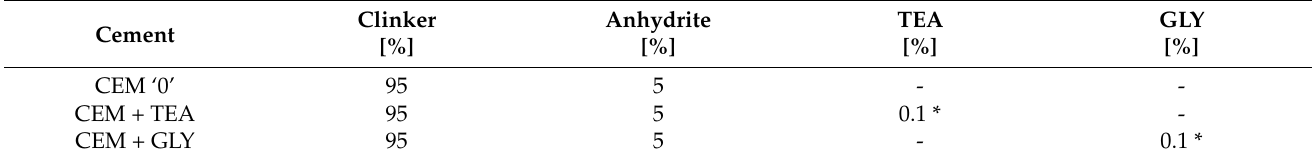
Table 2. Mix proportions of raw materials subjected to